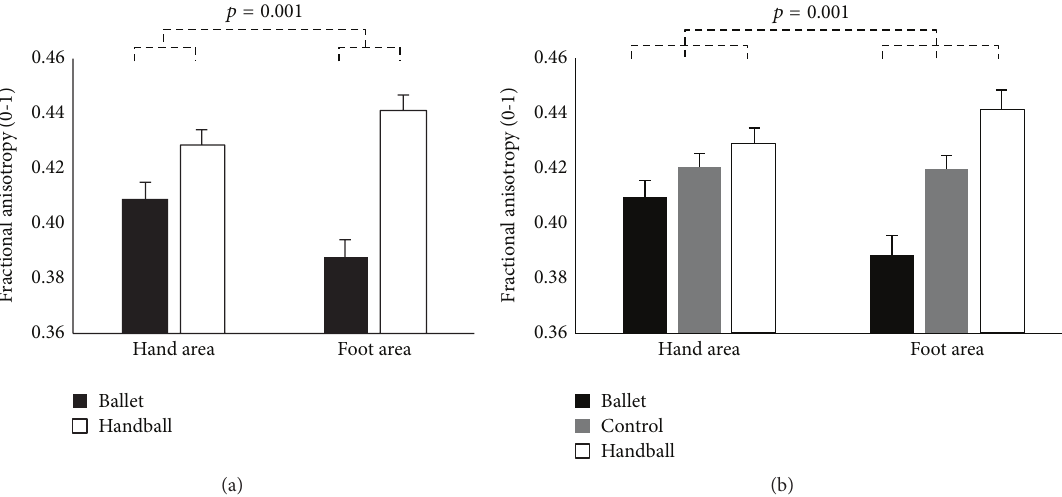
Figure 3: Estimated means and standard errors of fractional anisotropy (FA) in the corticospinal tracts originating in the hand and foot areas (independent of hemisphere and modality) for the ballet dancers ( 𝑛 = 10 ) and the handball players ( 𝑛 = 12 ) depicted on (a) (rmMANOVA including only the sports groups) and for the ballet dancers ( 𝑛 = 10 ) and the handball players ( 𝑛 = 12 ) and the control women ( 𝑛 = 22 ) depicted on (b) (rmMANOVA including all three groups). Note that reduced FA reflects sport-specific skills. p < 0.001